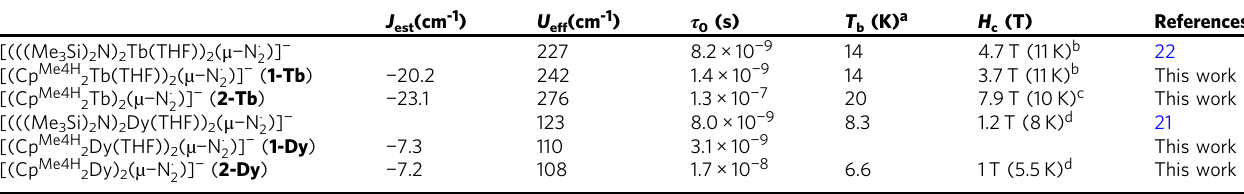
a Blocking temperature de fi ned as the temperature at which the magnetic relaxation time is 100s b Sweep rate =